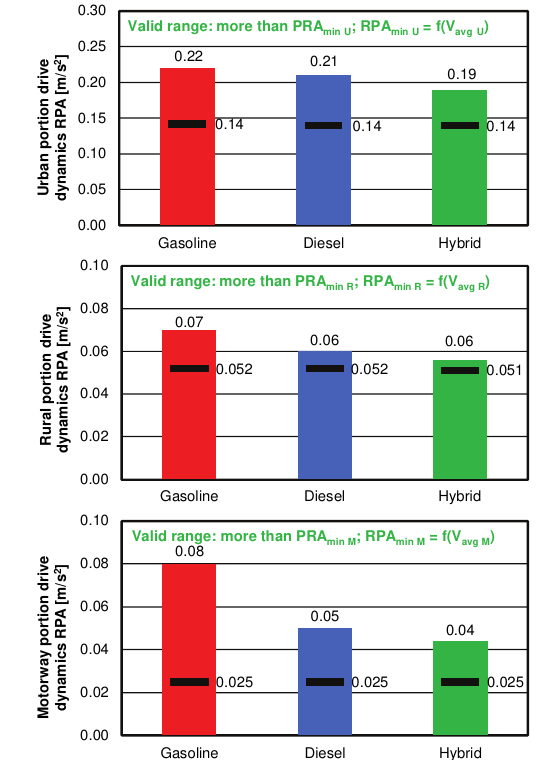
Fig. 12. Relative positive acceleration comparison of urban (a), rural (b) and motorway (c) test drives with the minimum value (required) and the